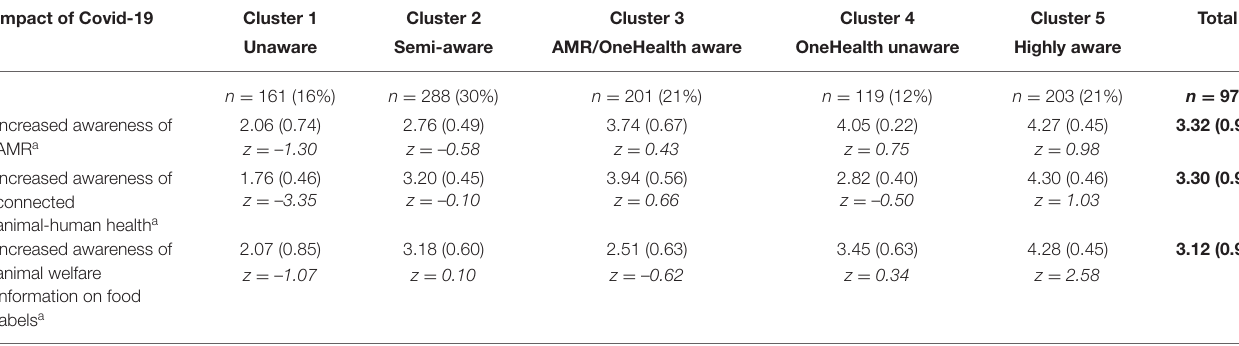
TABLE 1 | Means and standard deviations for the Covid-19 impact variables across the five